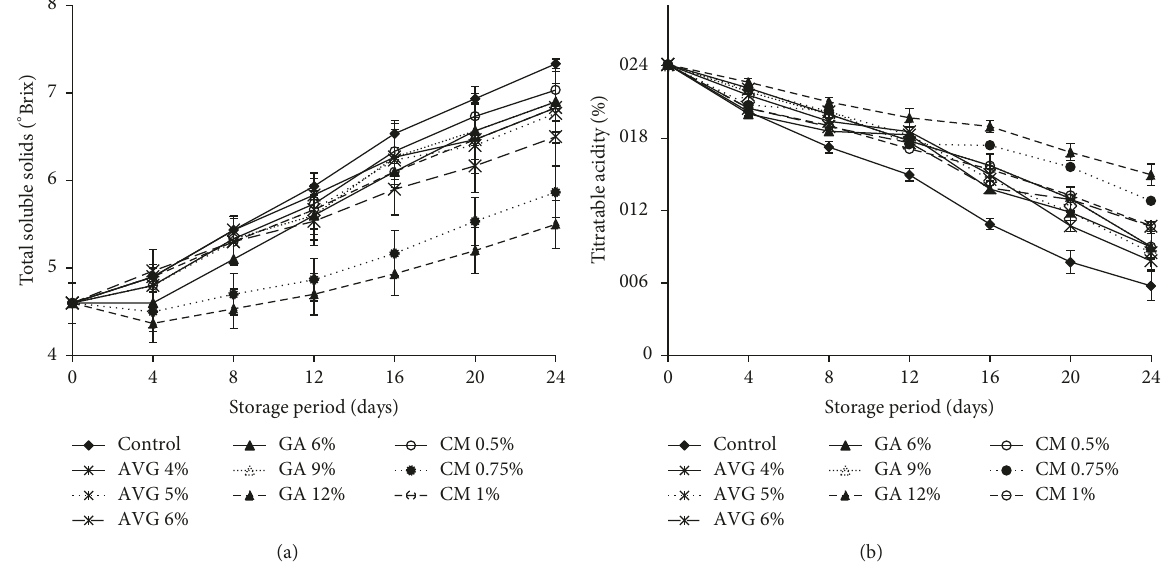
Figure 2: Effect of different coating treatments on the TSS and TA of bell pepper during cold storage at 8 ± 1 ∘ C for 24 days.